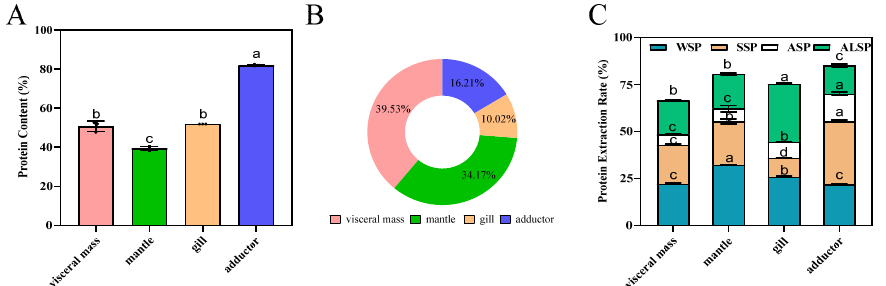
Figure 1. Composition of proteins from different parts of the oyster. ( A ): Protein content of visceral mass, mantle, gill, and adductor of the oyster. Different superscripts (a, b, c) indicate significant differences ( p < 0.05). ( B ): Proportion of protein content in oyster tissues. ( C ): Extraction rate of water-soluble protein (WSP), salt-soluble protein (SSP), acid-soluble protein (ASP), and alkali-soluble protein (ALSP) in oyster tissues, protein extraction rate (%) = protein mass in the extracted sample/total protein mass of the sample × 100%. Different superscripts (a–c) in the same color indicate significant differences ( p < 0.05).